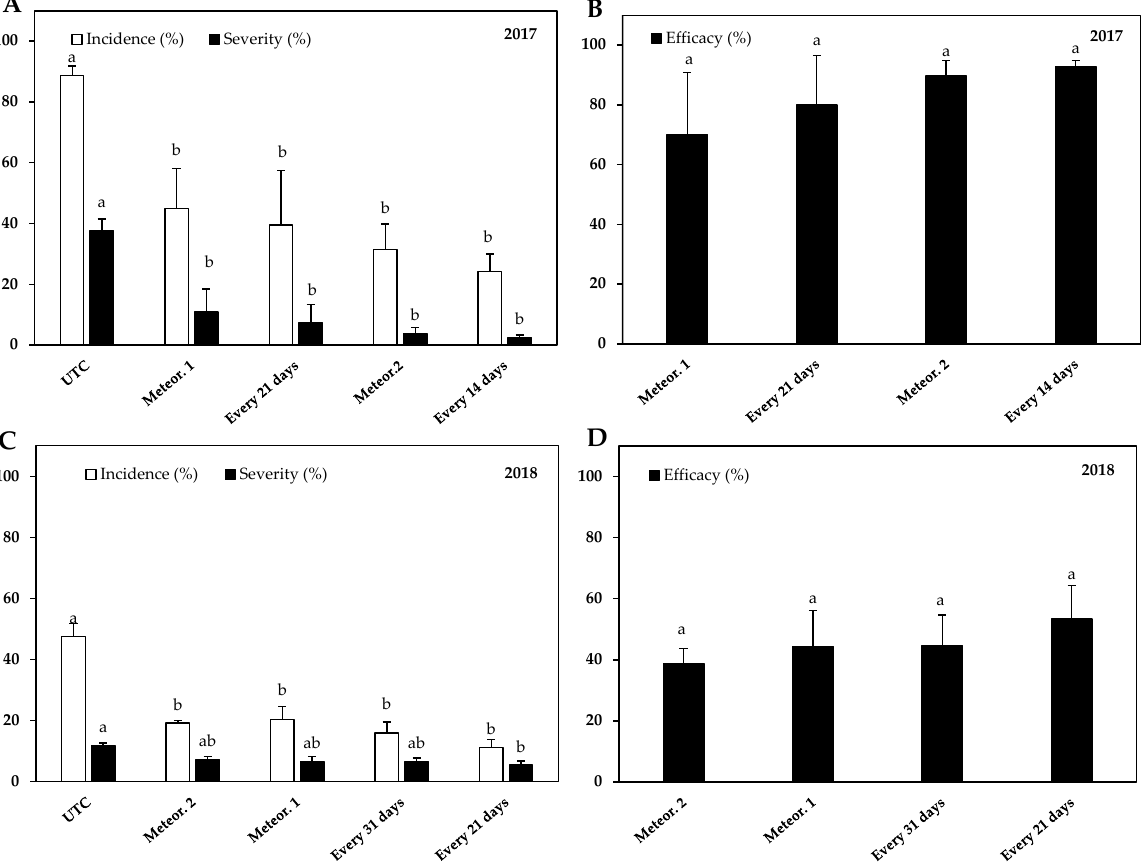
Figure 3. Disease incidence and severity ( A , C ) and control efficacy ( B , D ) of red leaf blotch in almond trees managed with different strategies of fungicide sprays (2017 and 2018). The efficacy was calculated using Abbott’s formula [29]. Treatment means with different letters are significantly different according to Tukey–Kramer’s test ( p < 0.05). The error bars indicate the standard error of the mean.